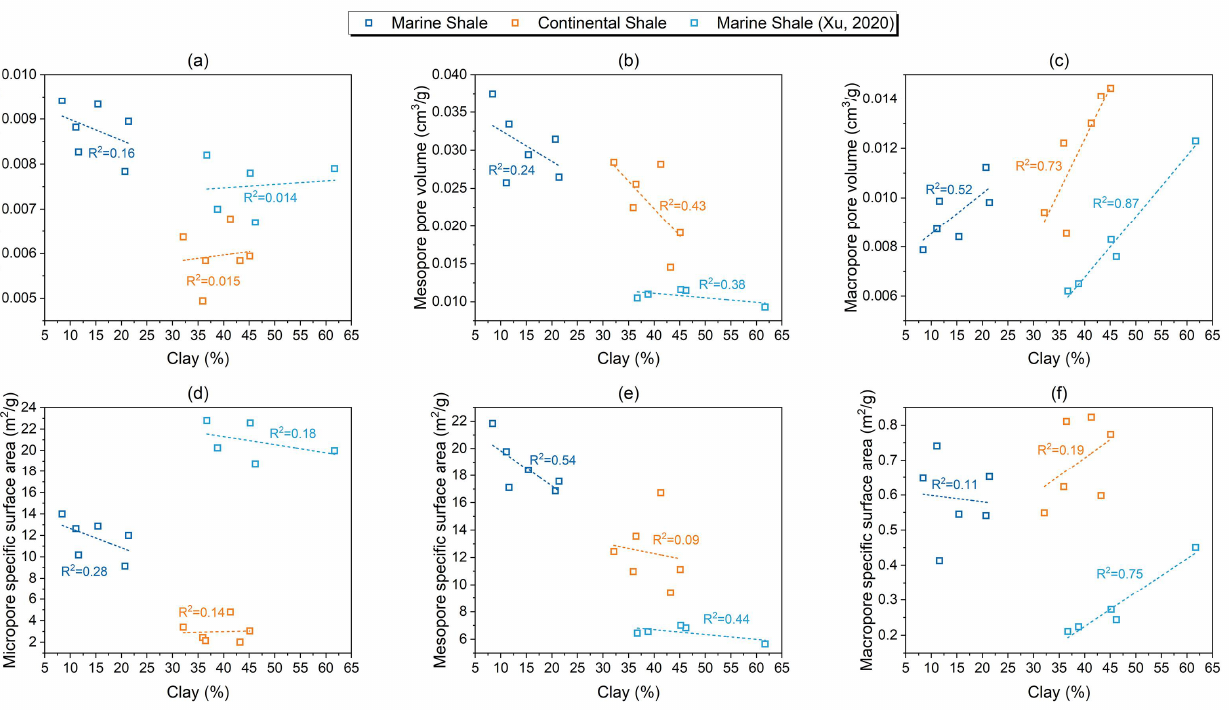
Figure 8. The correlation between the clay content and the pore volume ( a – c ) and the specific surface area ( d – f ). Part of data from (Xu et al., 2020) [20]. area ( d – f ). Part of data from (Xu et al., 2020)